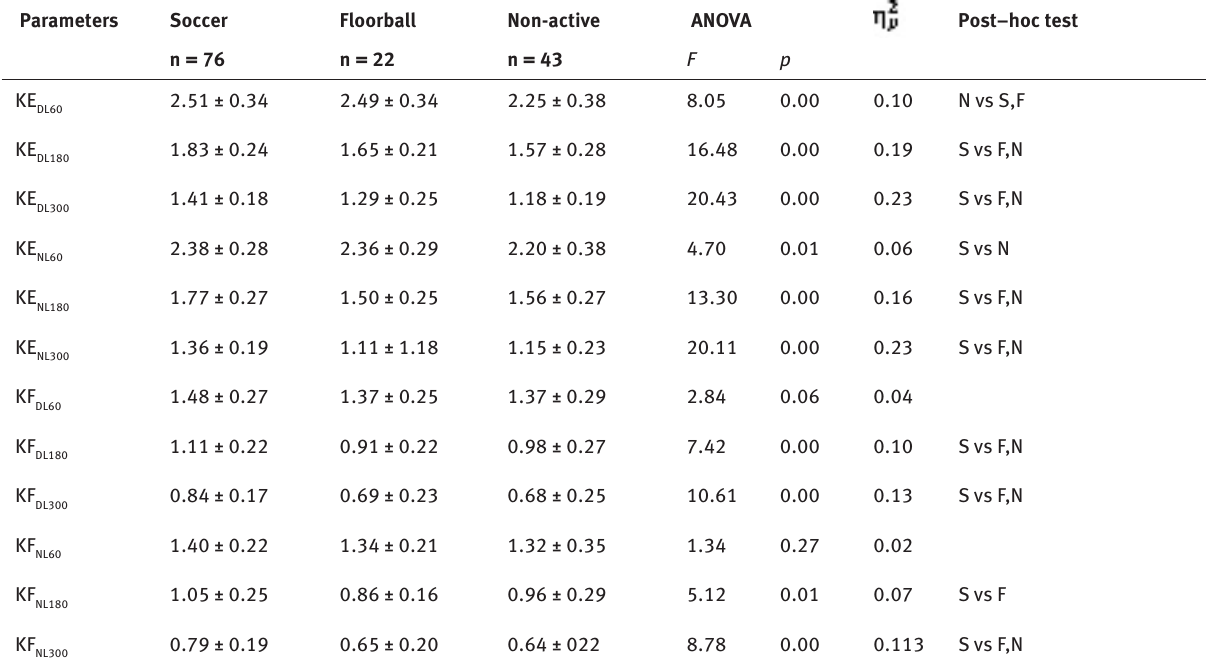
Table 3: Isokinetic strength (Nmkg -1 ) differences of knee extensors and flexors with respect to different sport activities at different contrac- tion velocities (60, 180, 300°s -1